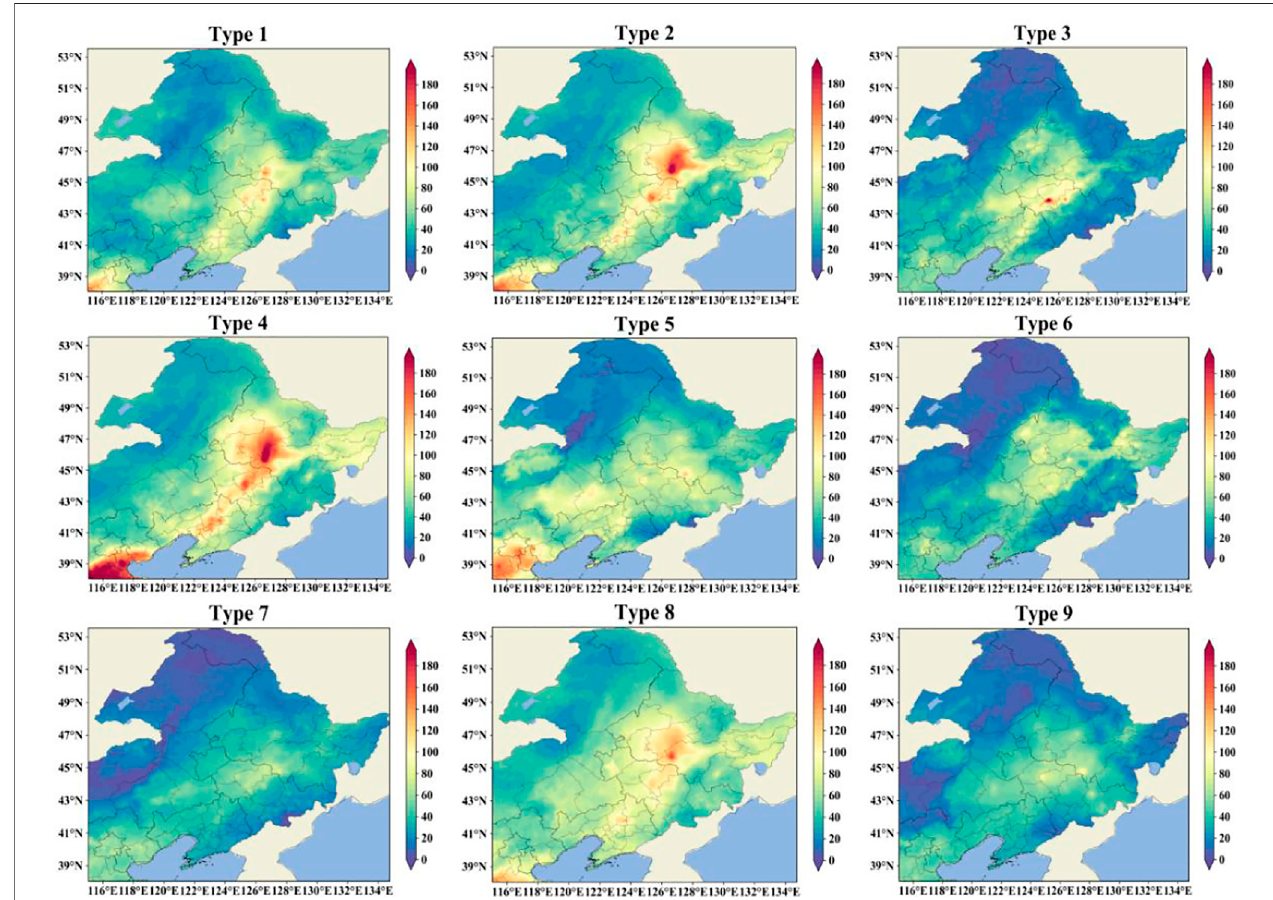
FIGURE 10 | Distribution characteristics of PM2.5 concentration during severe pollution periods under nine circulation